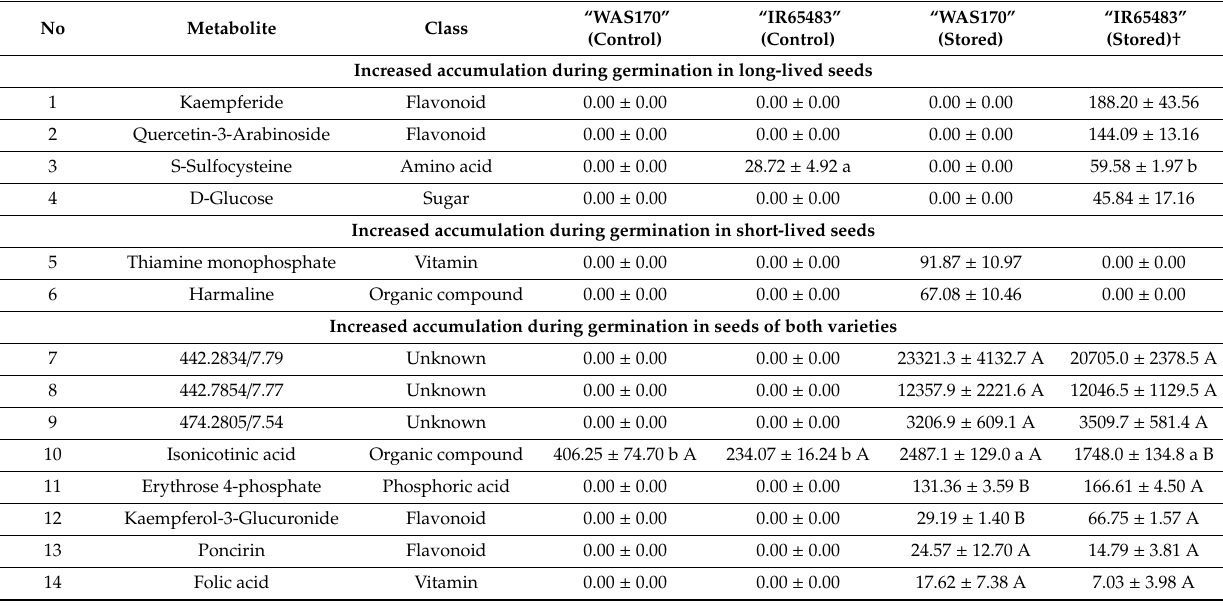
Table 1. Metabolites that showed the greatest variation between treatments during germination of “WAS170” (short-lived) and “IR65483” (long-lived) rice seeds after 0 (“control”) and 20 days storage (“stored”) at 10.9% moisture content (MC) and 45 ◦ C. Metabolites were determined by quadrupole time-of-flight (QTOF) mass spectrometry. The values (mean ± s.e. peak intensities for three ground samples of 50 seeds for each accession × storage treatment) are peak intensities from an extracted ion chromatogram.